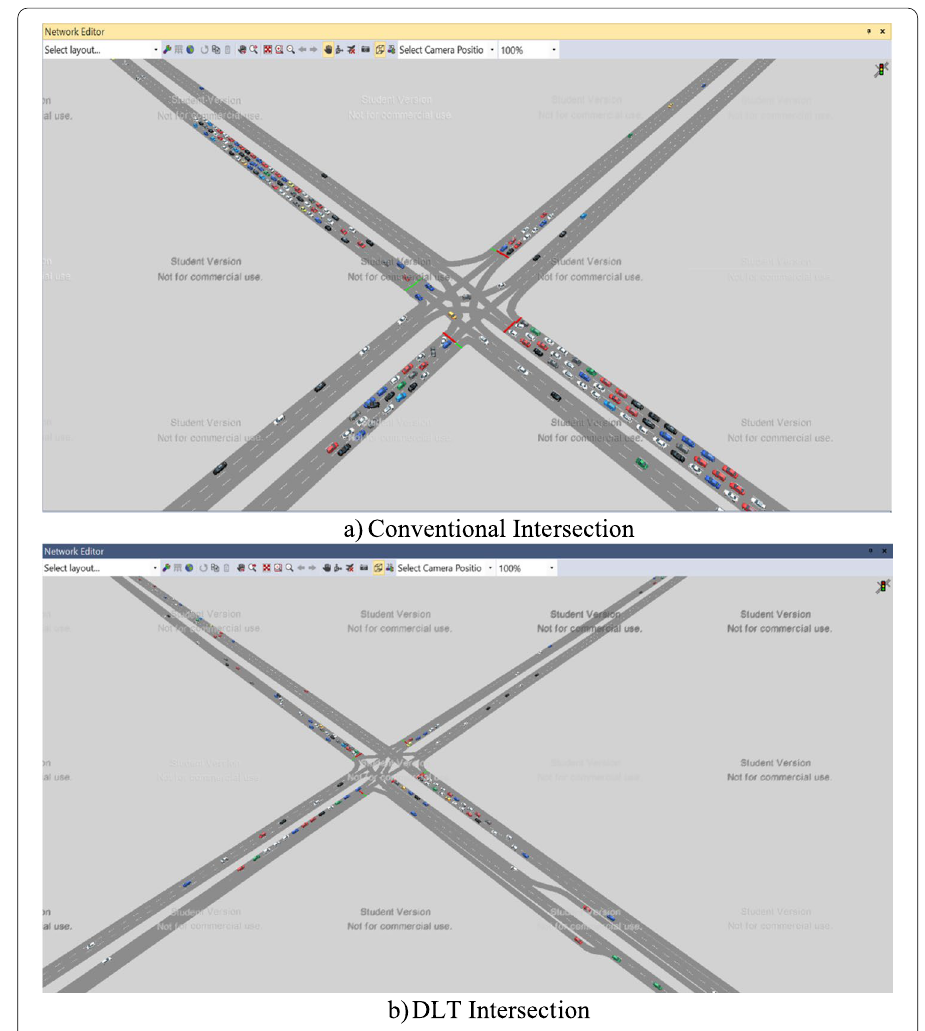
Fig. 10 Simulated results for queue length of conventional and DLT intersections